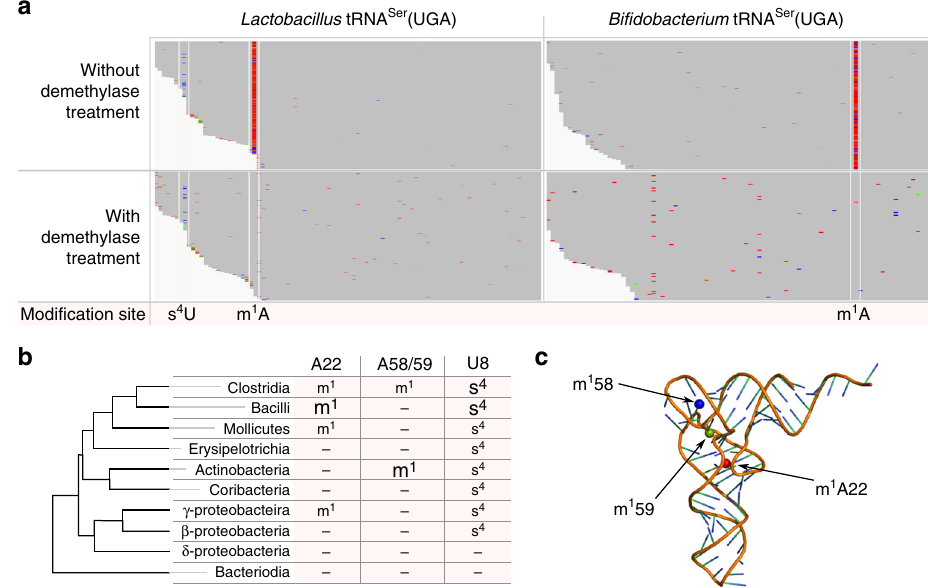
Fig. 5 Taxonomic differences of modi fi cation sites. a Examples of aligning tRNA sequencing reads to two seed sequences of tRNA Ser (UGA) from Lactobacillus , class Bacilli, and Bi fi dobacterium , class Actinobacteria without and with demethylase treatment. Modi fi cation sites identi fi ed (s 4 U and m 1 A) are highlighted between the white lines. b m 1 A22, m 1 A58/59, and s 4 U8 identi fi ed in the abundant bacterial classes from Fig. 3c in the context of their phylogenetic relationship. Large fonts indicate bacterial classes in which the majority of the modi fi cations are found (m 1 A22 in Clostridia and Bacilli, m 1 A58/59 in Actinobacteria, and s 4 U8 in Clostridia and Bacilli). c Proximal location of the m 1 A22 (red), m 1 58 (blue), and m 1 59 (green) modi fi cations in a tRNA three-dimensional